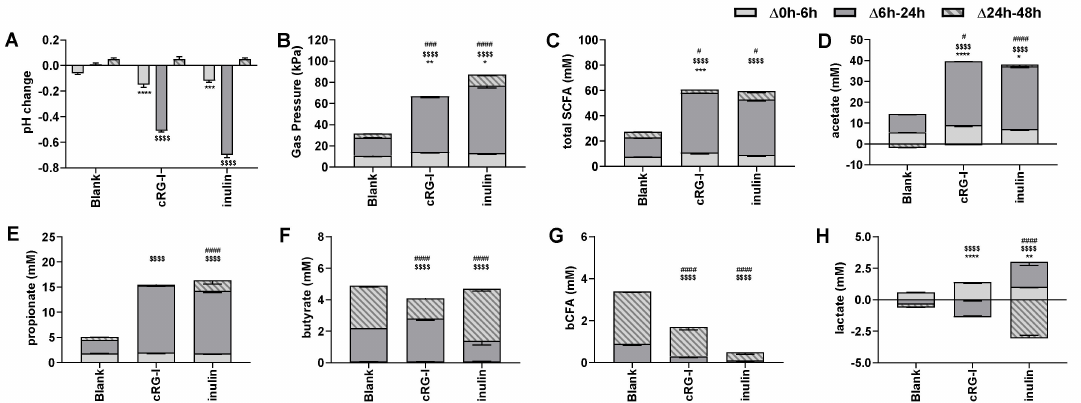
Figure 3. E ff ect of fermentation of cRG-I on microbial metabolic activity in short-term colonic incubations. Average changes ( ± st. dev.) in pH ( A ), gas production ( B ), total short-chain fatty acids (SCFA) ( C ), acetate ( D ), propionate ( E ), butyrate ( F ), branched CFA (bCFA) ( G ) and lactate ( H ) levels between 0 and 6 h (light gray), 6 h and 24 h (dark gray) and 24 h and 48 h (stripes) upon dosing cRG-I and inulin to the gut microbiota versus a blank incubation ( n = 3). Statistically significant di ff erences between blank and treatments for di ff erent time intervals are presented by * for ∆ 0 h–6 h, $ for ∆ 6 h–24 h or # for ∆ 24 h–48 h. (*, $, #) = p < 0.05, (**, $$, ##) = p < 0.01, (***, $$$, ###) = p < 0.001 and (****, $$$$, ####) = p <